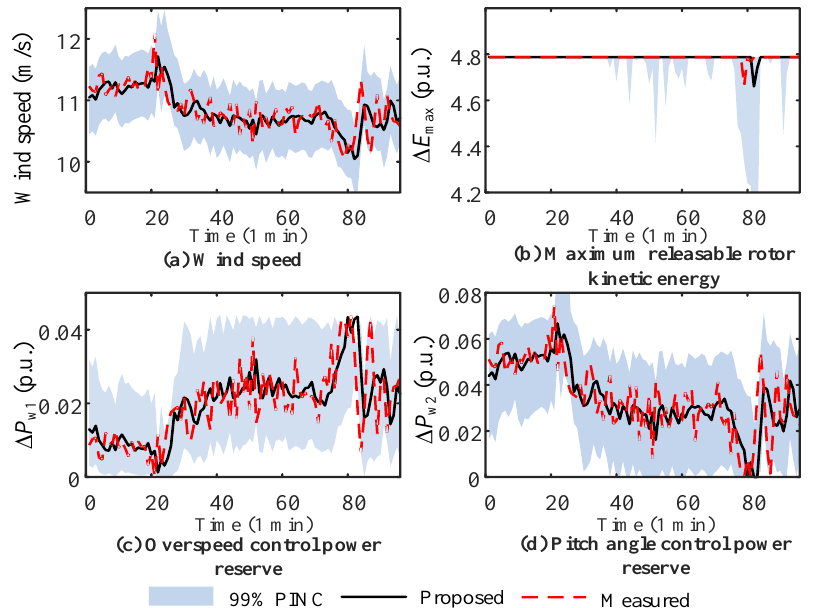
Figure 8. Probabilistic prediction results. In terms of probabilistic prediction, SSA-GPR and error statistics methods were se- lected as the comparison methods. Table 2 gives a comparison of the probabilistic prediction performance, and the proposed methods can maintain relatively excellent performance at all confidence levels, with the smallest uncertainty of PINAW prediction results. The ACE of each probabilistic prediction model is close to 0 with little difference, indicating that different models have good interval coverage. Different confidence levels have a great impact on the model performance of probability prediction. Comparing the comprehensive index CWC, the method in this paper has a smaller CWC as the confidence level decreases, which indicates a stronger robustness and can give full play to the characteristics of GPR in probability prediction such as smaller model bias, good robustness, and wide applicability. Table 2. Probabilistic prediction performance. Method